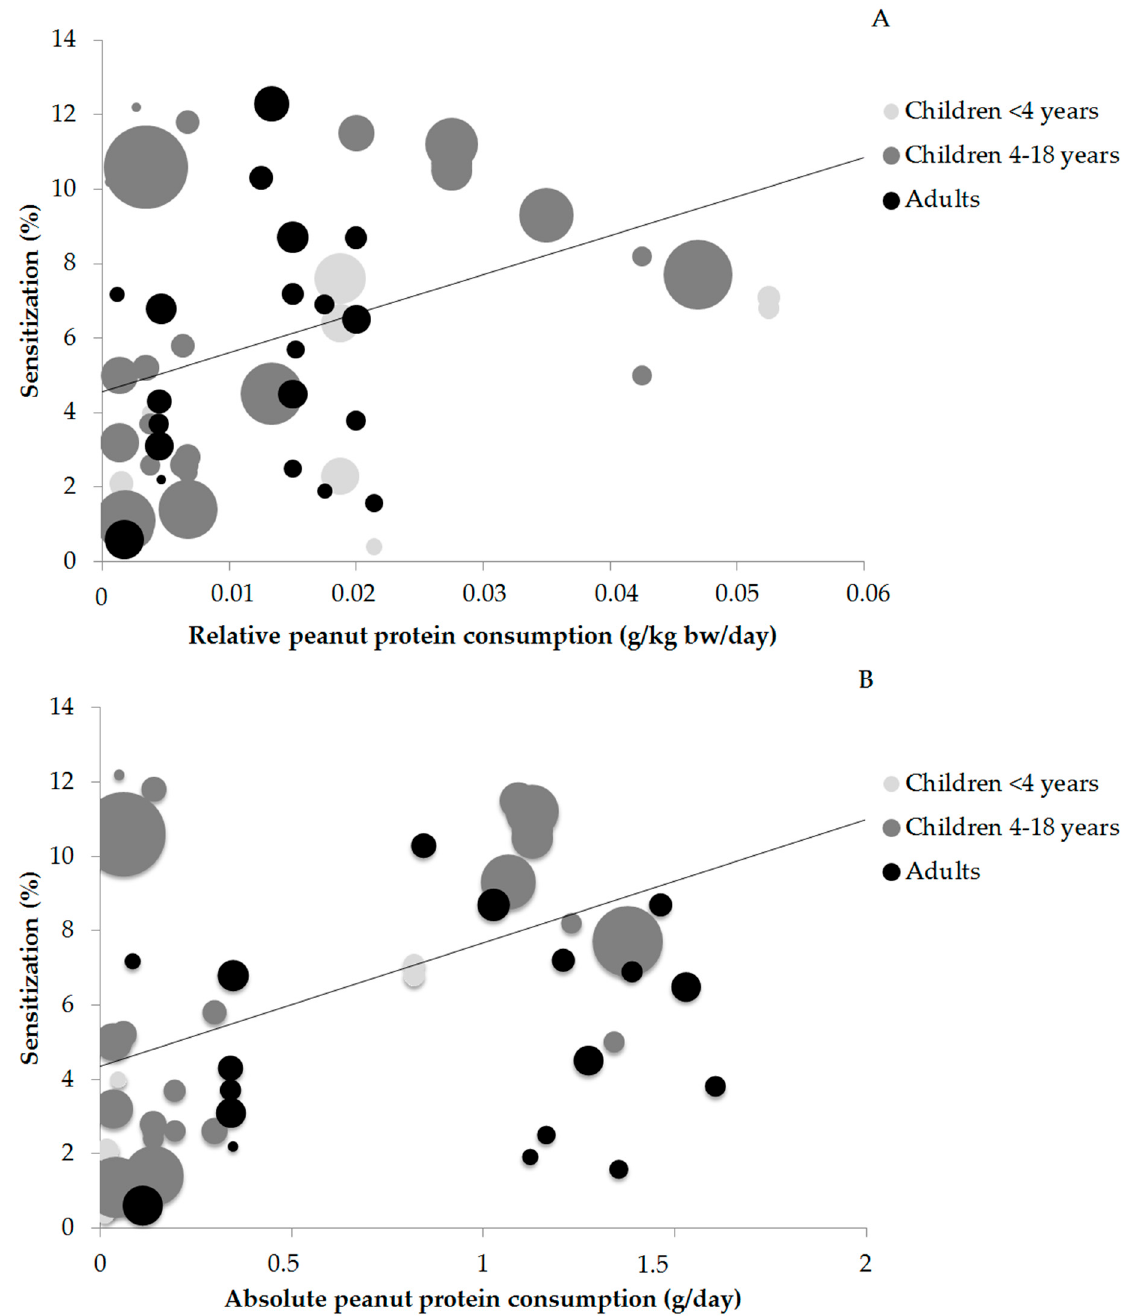
Figure 2. ( A ) Relation between relative peanut protein consumption (in g/kg bw/day) and reported peanut sensitization (%) in children <4 years; children 4–18 years; and adults. r values of respectively 0.505 ( p > 0.05), 0.415 ( p < 0.05), and 0.441 ( p > 0.05) were found. The line represents the trend for all ages. ( B ) Relation between absolute peanut protein consumption (in g/day) and reported peanut sensitization in children <4 years; children 4–18 years; and adults. r values of respectively 0.493 ( p < 0.05) in children 4–18 years and 0.461 ( p > 0.05) were found in adults. The line represents the trend for all ages.